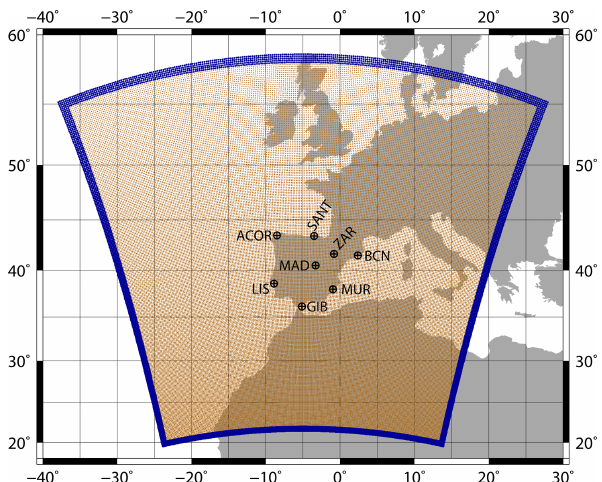
Figure 1. The domain used in both WRF simulations is presented with dark orange dots, while the dark blue region highlights the relaxation zone. The location of all the radiosondes available over the IP is also presented with quartered